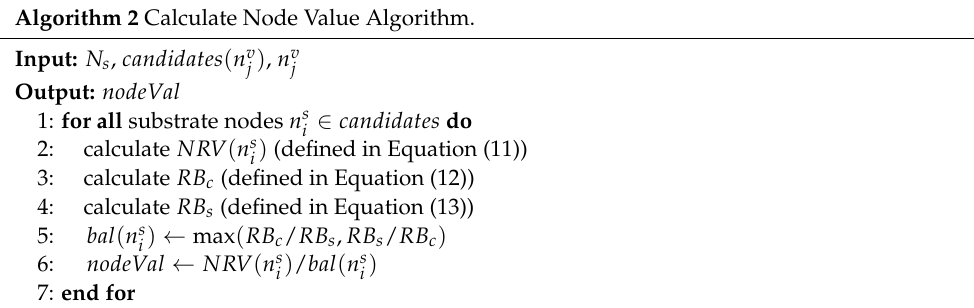
Algorithm 2 Calculate Node Value